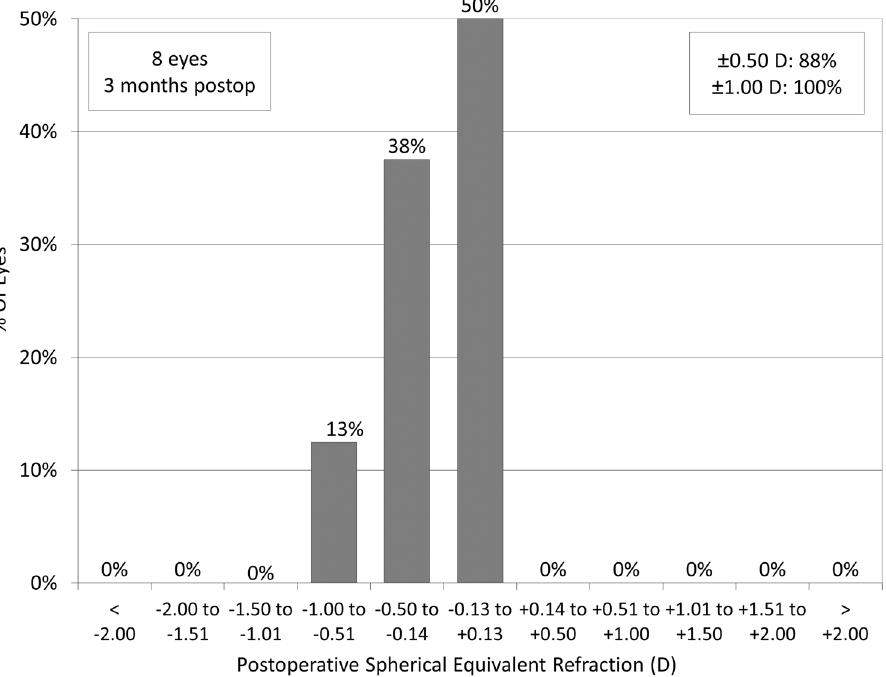
Figure 4. Percentages of eyes within different diopter ranges of the attempted spherical equivalent correction after implantable collamer lens (ICL)